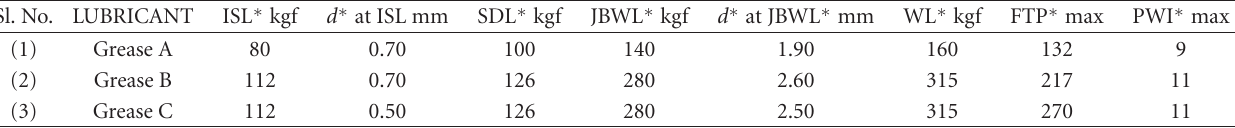
Table 2: Summary of the experimental results obtained with prepared Grease A, Grease B, and Grease C in the four-ball test. Sl. No. LUBRICANT